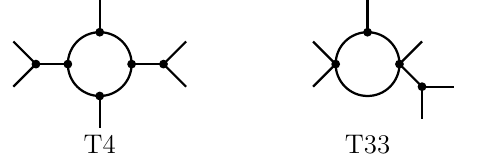
Figure 5 . Two example d = 7 topologies which always will be accompanied by a tree-level seesaw d = 5 contributions to the neutrino mass matrix. For discussion see